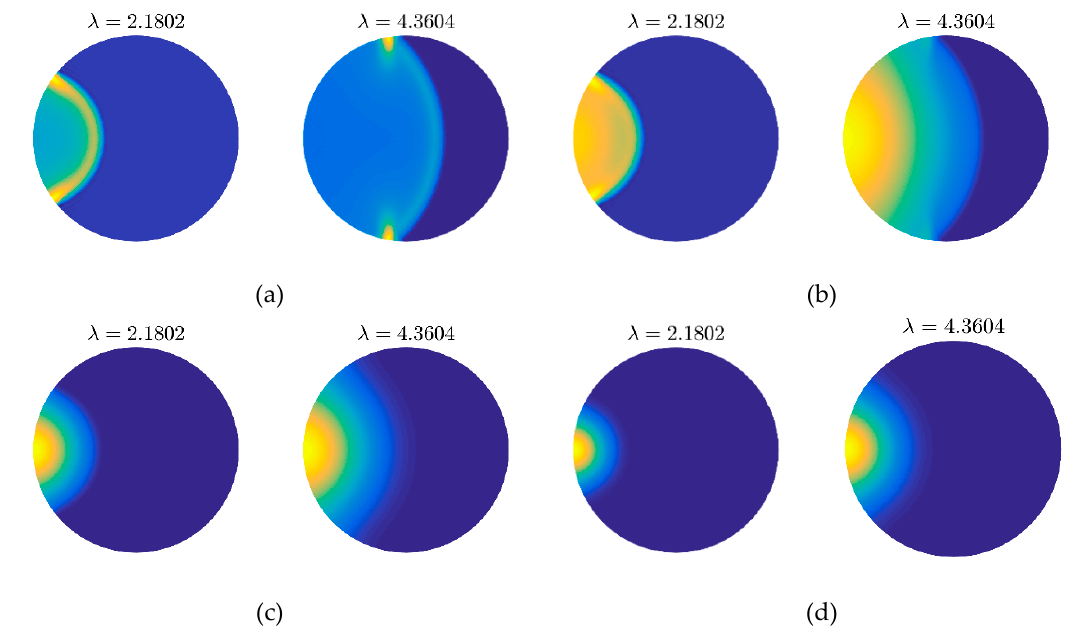
Figure 7. Thermal behaviors (snapshots) obtained by mesh grid in Figure 6a with di ff erent λ T : ( a ) wavy behavior λ T = 0; ( b ) wavelike behavior λ T = 0.1; ( c ) di ff usive behavior λ T = 0.5; ( d ) over di ff usive behavior λ T =